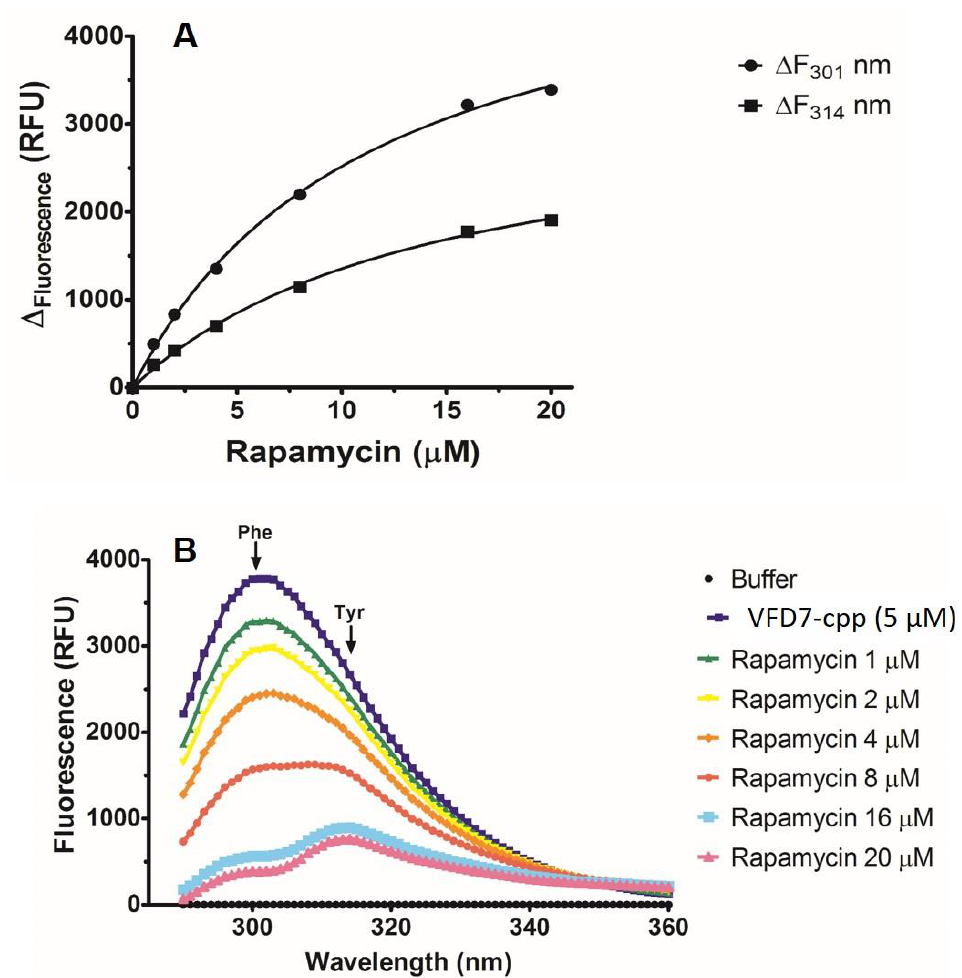
Figure 2. Evaluating the direct molecular interaction between VFD7 and rapamycin. ( A ) The variation ( ∆ fluorescence ) of the intrinsic fluorescence emission of the peptide VFD7-cpp (5 µ M) at 301 nm (Phe residue) and 314 nm (Tyr residue) in function of the rapamycin concentration (0–20 µ M) was monitored in 20 mM Tris-HCl buffer, pH 7.5 at 25 ◦ C. The kinetic analysis shows that rapamycin binds to VFD7-cpp at a single site by a saturable bimolecular reaction with an apparent K d of 13 ± 1 µ M. ( B ) Changes of VFD7-cpp intrinsic fluorescence emission spectra (290–360 nm) after excitation at λ ex = 275 nm plus/minus rapamycin (0–20 µ M). Increasing rapamycin concentration proportionally resulted in a progressive decrease in the fluorescence emission spectra of the peptide. Additional details were presented in Experimental